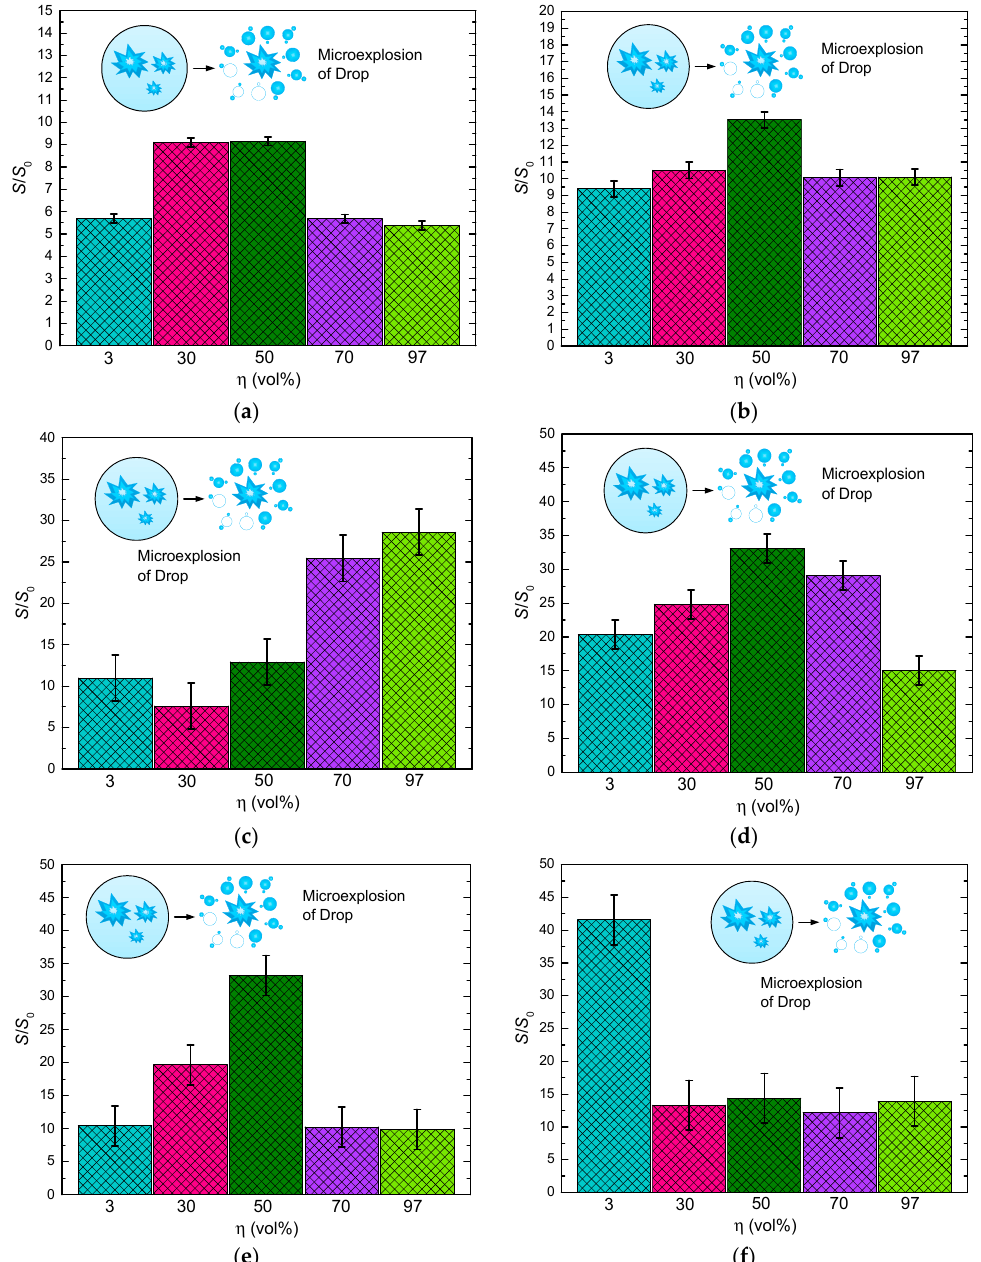
Figure 6. Ratios of surface areas of small droplets formed after the breakup of two-component droplets to their initial areas depending on the concentration of flammable liquid (oil) on various holders: ( a ): ceramics; ( b ):steel; ( c ): aluminum; ( d ): steel tube; ( e ): nichrome; ( f ): phosphorus. A literature analysis shows that it is possible to significantly reduce the size of the droplets of various liquids (respectively, to increase S / S 0 ), due to several mechanisms. The most common are the following: the impact of the droplets between themselves; the interaction of droplets with an obstacle; the acceleration of droplets to the conditions under which they lose their stability and are significantly transformed; micro-explosive crushing due to overheating.